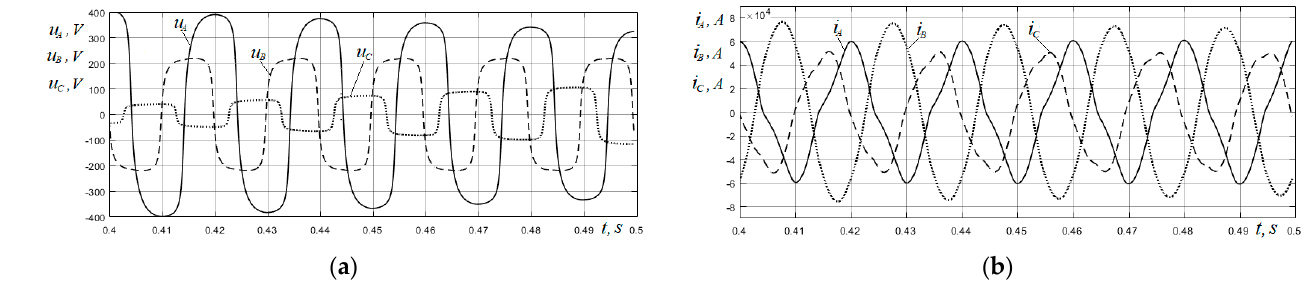
Figure 8. Time dependences of arcs: ( a ) voltages; ( b ) currents instantaneous values when handling asymmetric deterministic perturbations using fuzzy model (6).